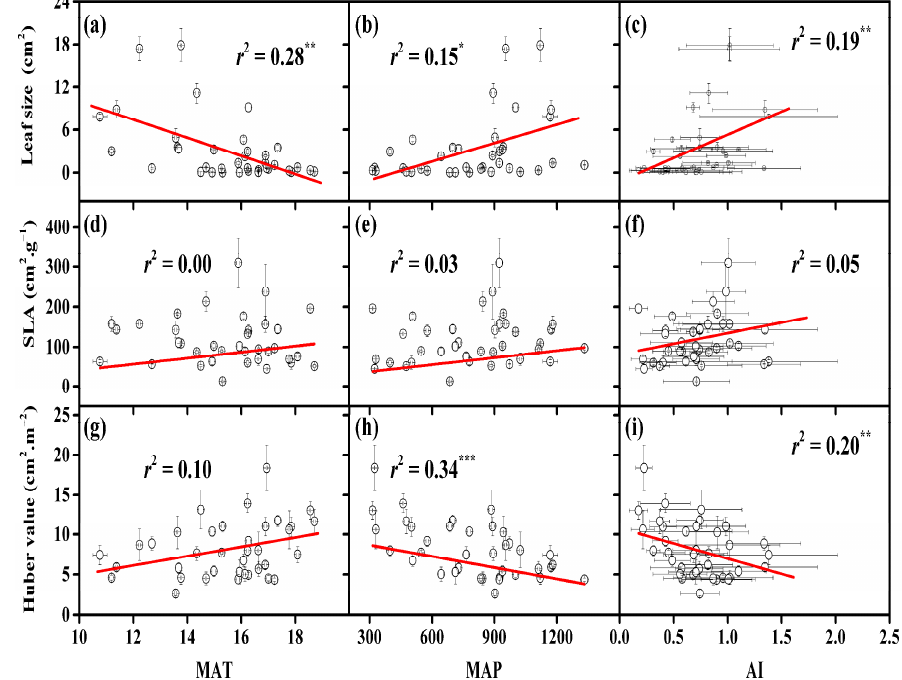
Figure 2. Influence of mean annual temperature (MAT), mean annual precipitation (MAP), and annual aridity index (AI) at each species’ natural geographical distribution on ( a – c ) leaf size, ( d – f ) specific leaf area (SLA), and ( g – i ) Huber value. The solid curved line represents the nonlinear fitting, and the solid straight lines represents the linear regression. Associated r 2 values are provided (* P < 0.05, ** P < 0.01, *** P < 0.001). Data are means ± 1 SE.